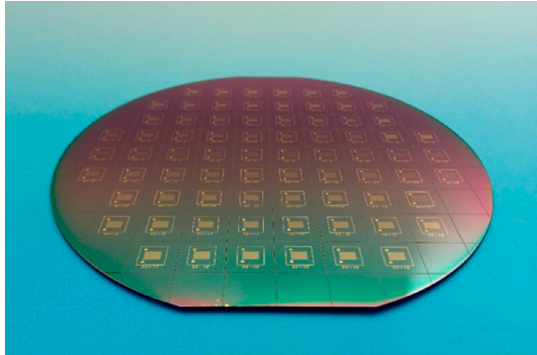
Figure 2. Gold-film temperature sensors fabricated on a 4-inch silicon wafer.